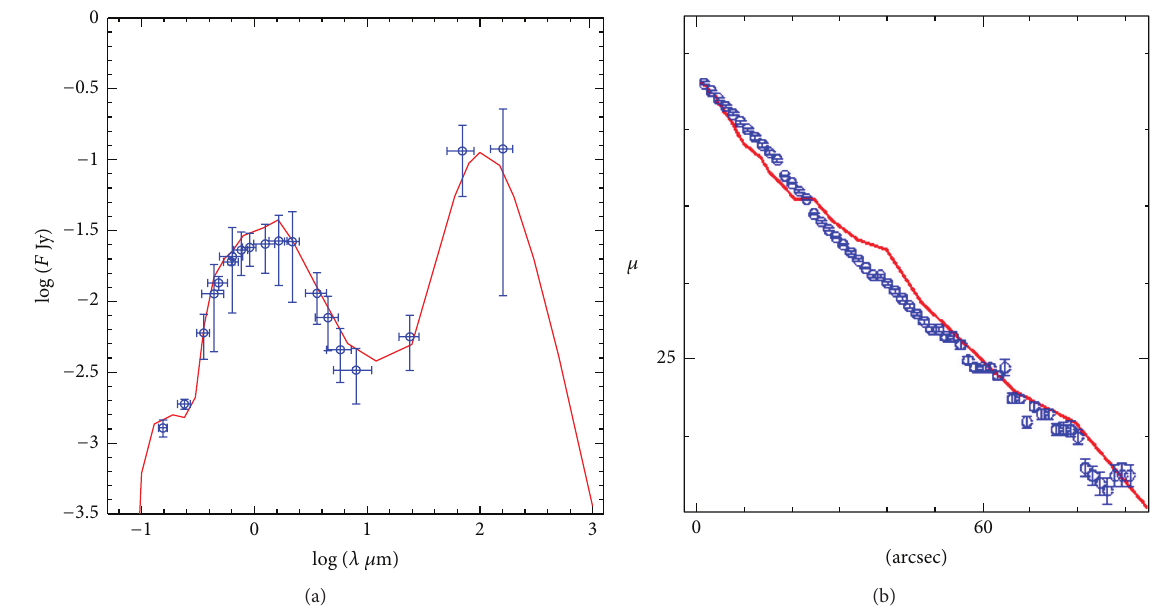
Figure 5: (a) the SED of UGC 7639. Blue filled circles correspond to UV/Optical/IR/FIR data, in particular FUV and NUV total fluxes from Table 1, u, g, r, i, and z, fluxes from NASA-Sloan Atlas [29], B and R from Bremnes et al. [20], and IR and FIR from Dale et al. [53]. Error bars account for bandwidth and 3 𝜎 flux uncertainties. The solid (red) line shows the prediction of our model (see text). (b) the r-band luminosity profile of our simulated image in Figure 4 is compared with that measured in the same band and shown in Figure 2. Error bars < 1% do not appear in the